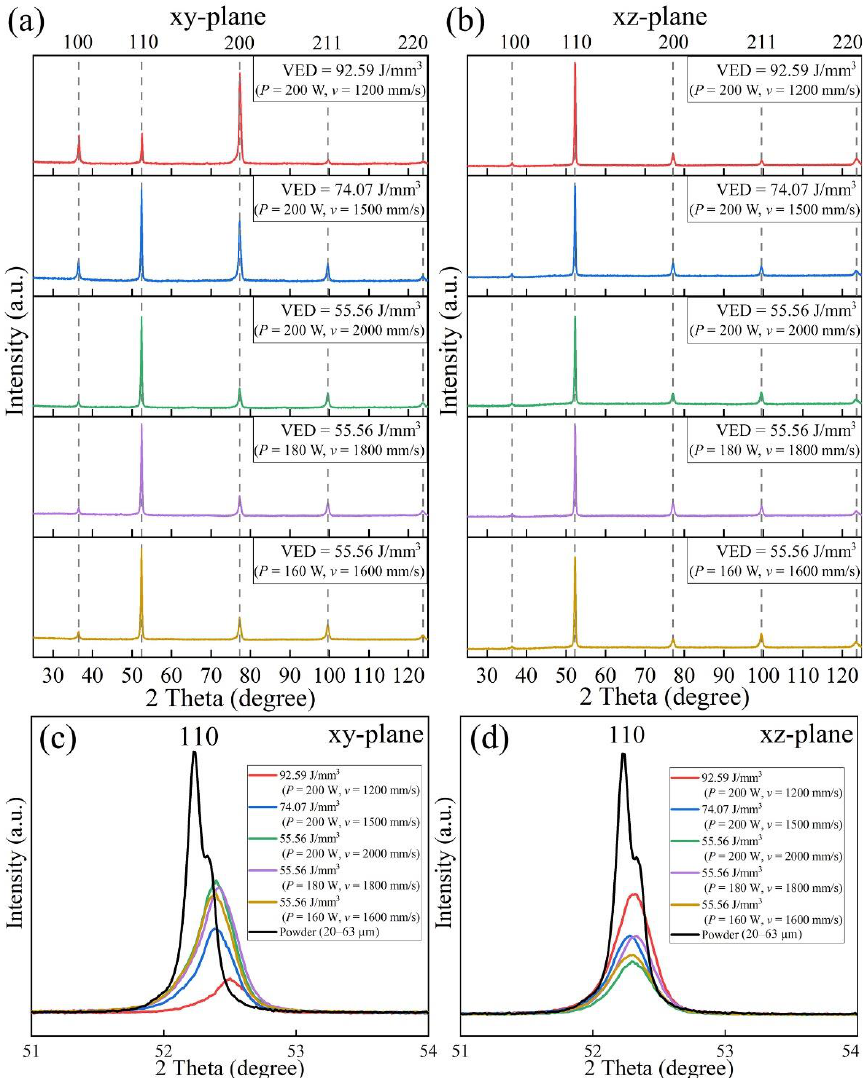
Figure 5. XRD patterns of as-printed AlCoCr 0.75 Cu 0.5 FeNi specimens analyzed on ( a ) xy-plane and ( b ) xz- plane, magnified 2θ of 110 peak on ( c ) xy-plane and ( d ) xz-plane. The EBSD analyses of inverse pole figure (IPF) maps on the xy-plane of LPBF-built AlCoCr 0.75 Cu 0.5 FeNi specimens are illustrated in Figure 6. All the specimens display the polygonal equiaxed grains on the xy-plane, and only BCC structure has been identified. The grain size of each specimen is shown on the left corner of each map. The finest grain size of ~9.47 μm is produced when the scanning speed reaches the highest value of 2000 mm/s under the laser power of 200 W, indicating that grain size increases with the de- creasing applied scanning speed when the same laser power is employed.